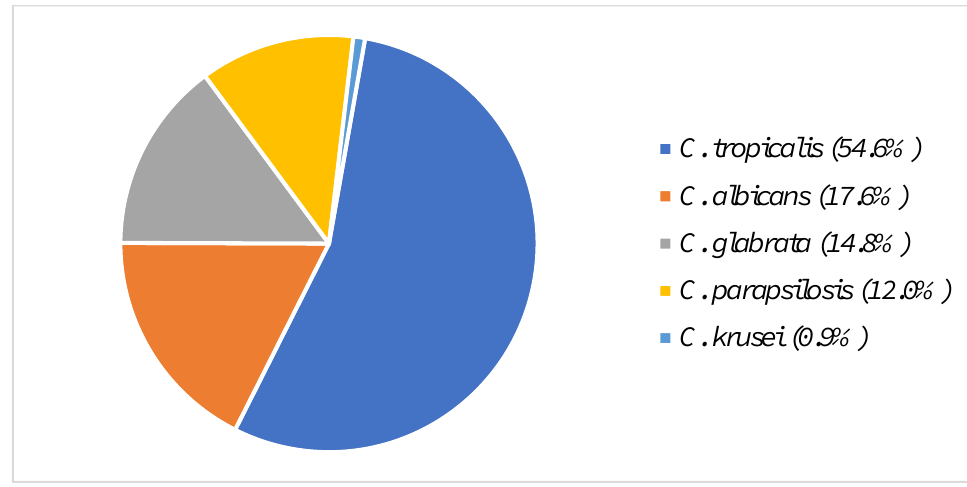
Figure 2. Candida isolates recovered in this study.